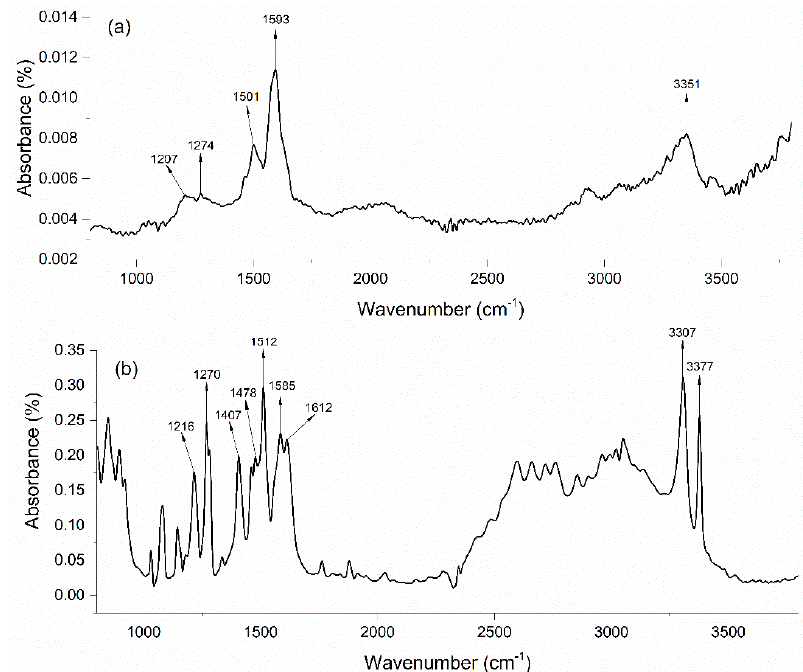
Figure 3. FTIR spectrum of ( a ) PoAP–MEL film ( b ) oAP. Table 1. FTIR peaks assignment for PoAP–MEL and